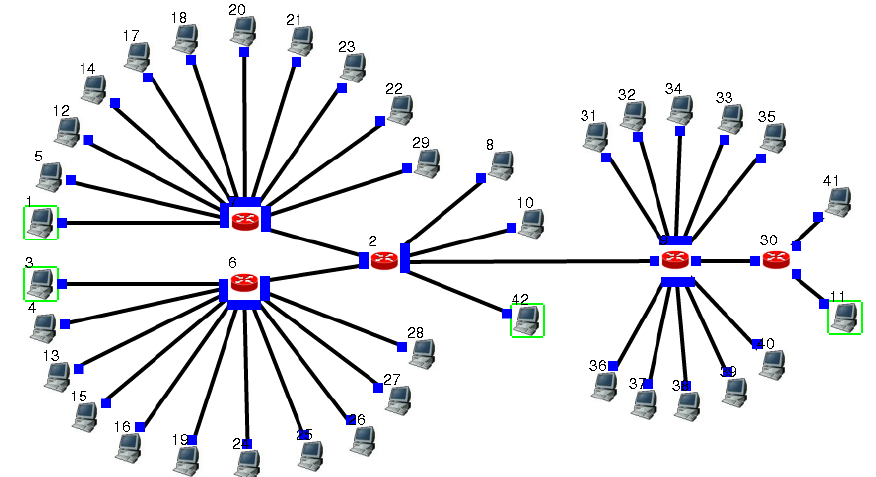
Figure 3. Network topology diagram of the synchronization delay test.